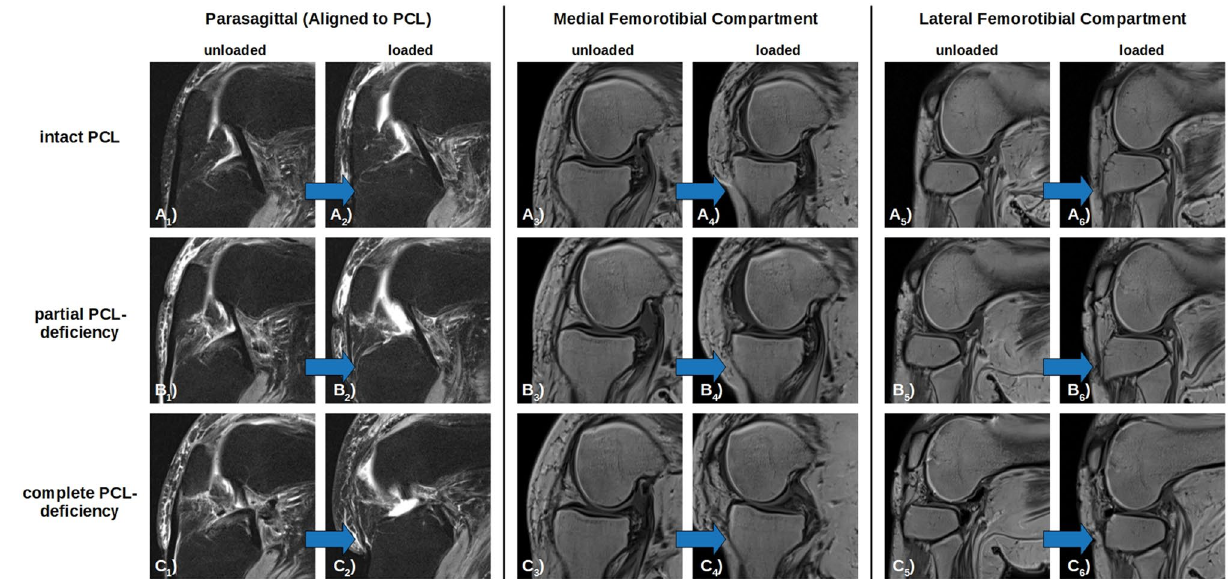
Figure 2. Loading-Induced Changes in the Knee Joint as a Function of PCL Injury and Loading. Displayed are the unloaded ( A 1 – C 1 , A 3 – C 3 , A 5 – C 5 ) and loaded ( A 2 – C 2 , A 4 – C 4 , A 6 – C 6 ) configurations of the PCL-intact ( A ), partially PCL-deficient ( B ), and completely PCL-deficient ( C ) conditions. Images were acquired along the course of the PCL (parasagittal, PD-weighted fat-saturated sequence [ A 1 – C 1 , A 2 – C 2 ]) and along the central medial ( A 3 – C 3 , A 4 – C 4 ) and lateral ( A 5 – C 5 , A 6 – C 6 ) femorotibial compartments (sagittal, T1-weighted sequences). Blue block arrows indicate the direction of loading. Posterior tibial translation increased as a function of loading and PCL injury and was larger in the lateral than medial femorotibial compartment. Same left knee joint specimen as in Fig. 1 and Supplementary Figs. 1 and 2.